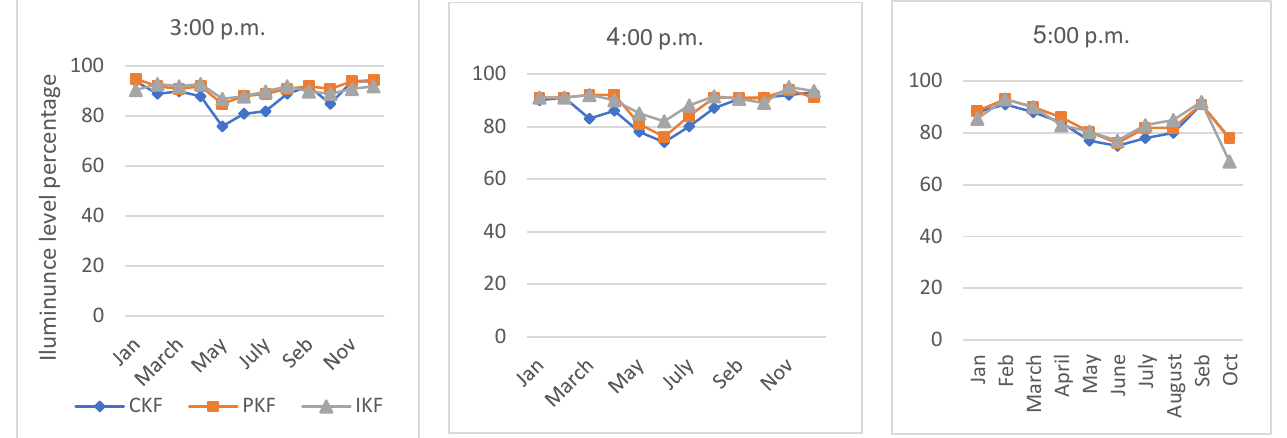
Figure 9. Illuminance level percentage between 200 – 1000 lux, as a result of three proposed systems.